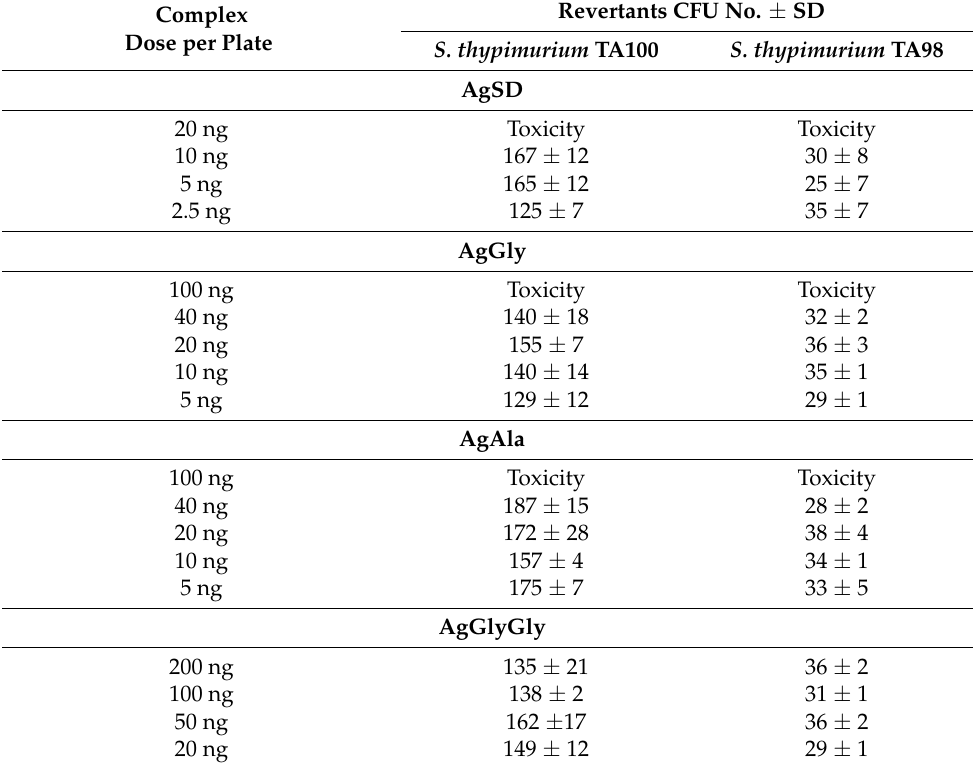
Table 4. Results of Ames